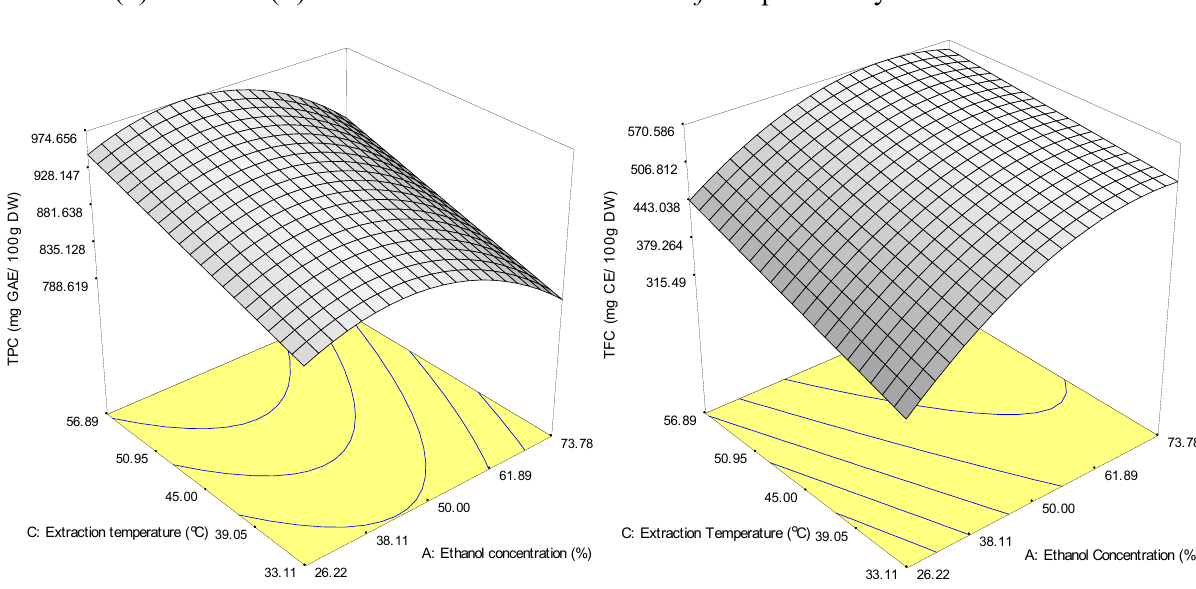
Figure 1. Response surface plot for the effects of extraction conditions on the recovery of TPC ( a ) and TFC ( b ) of ethanol extracts from M. citrifolia powder by solvent